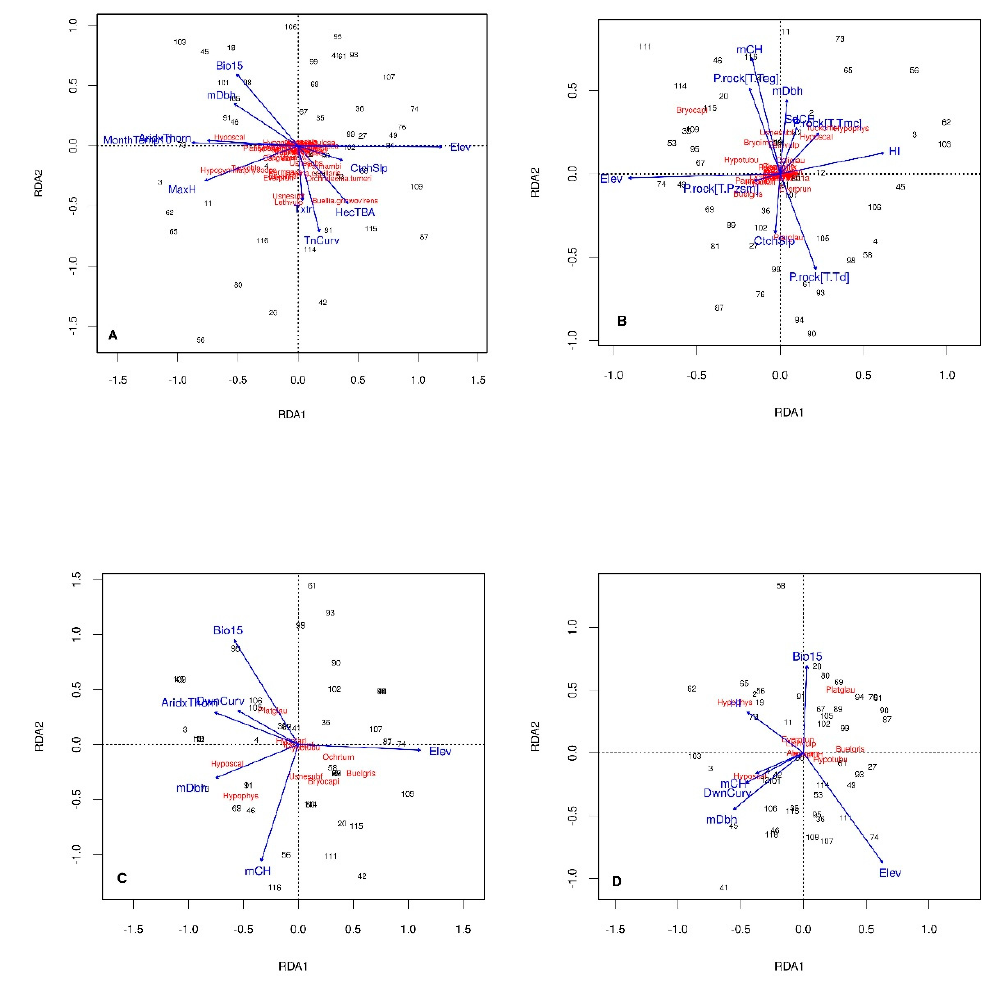
Figure 3. Ordination biplot of the stand level redundancy analysis of epiphytic lichen species. Distribution related to environmental variables: ( A ) LPA, ( B ) LFQ, ( C ) GLPA, and ( D ) GLFQ. Species are indicated by red labels and abbreviated with cepnames. Explanatory variables are indicated using blue arrows.